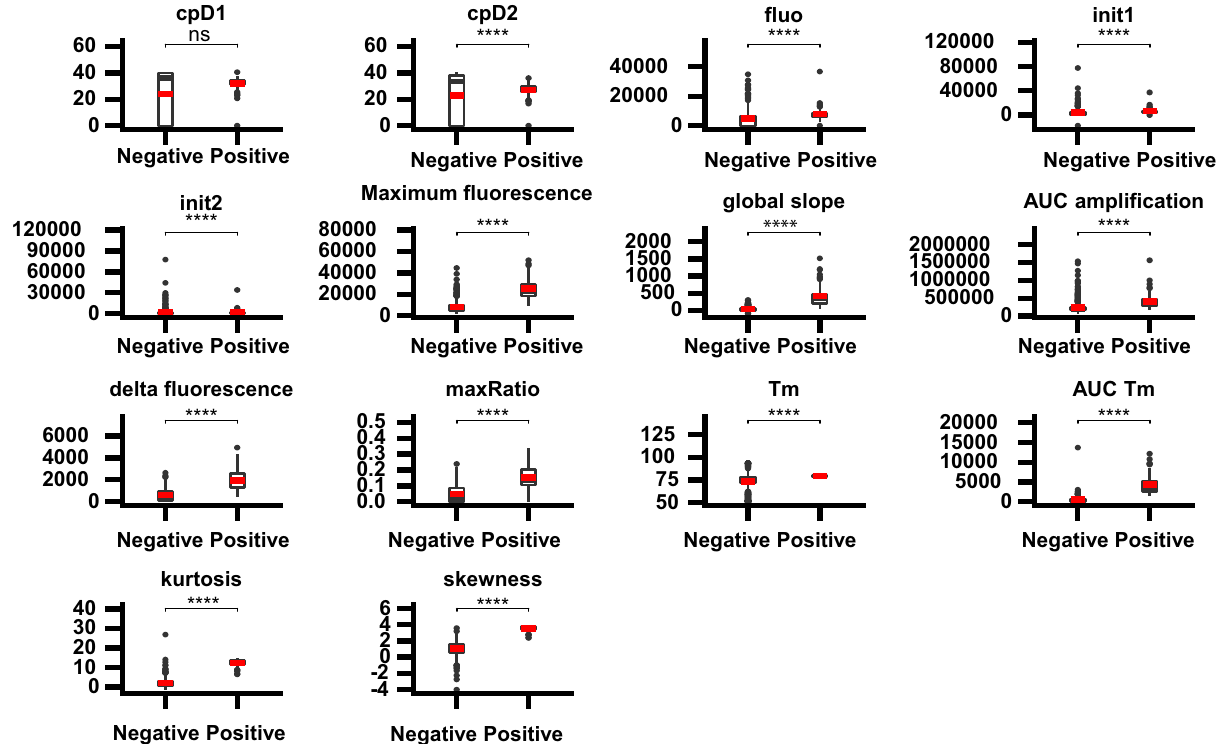
Figure 2. Boxplots of 14 features calculated from the intercalating dye-based quantitative PCR curves comparing positive and negative classes. Notes : The mean is represented by a red crossbar; means were compared using Wilcoxon rank sum test:****(significant difference with p value < 10–4 and ns (non significant difference with p value > 0.05). cpD1 (Cp at the first maximum derivative of the amplification curve); cpD2 (Cp at the second maximum derivative of the amplification curve); fluo (the fluorescence value the maximum of the second derivative curve (cpD2)); init1 (the initial template fluorescence from the sigmoidal model); init2 (the initial template fluorescence from an exponential model); maximum fluorescence (the maximum of fluorescence of the amplification curve); global slope (the slope of the amplification curve using a linear regression model); AUC amplification (Area Under the amplification Curve); delta fluorescence (the difference of fluorescence between the minim and the maximum of fluorescence); maxRatio (this method allows the identification of a coherent point in or very close to the exponential region of the qPCR signal). Tm (melting temperature), AUC Tm: area under the melting curve, kurtosis (measure of shape concerning the melting curve) and skewness (Skewness, measure of asymmetry of the melting